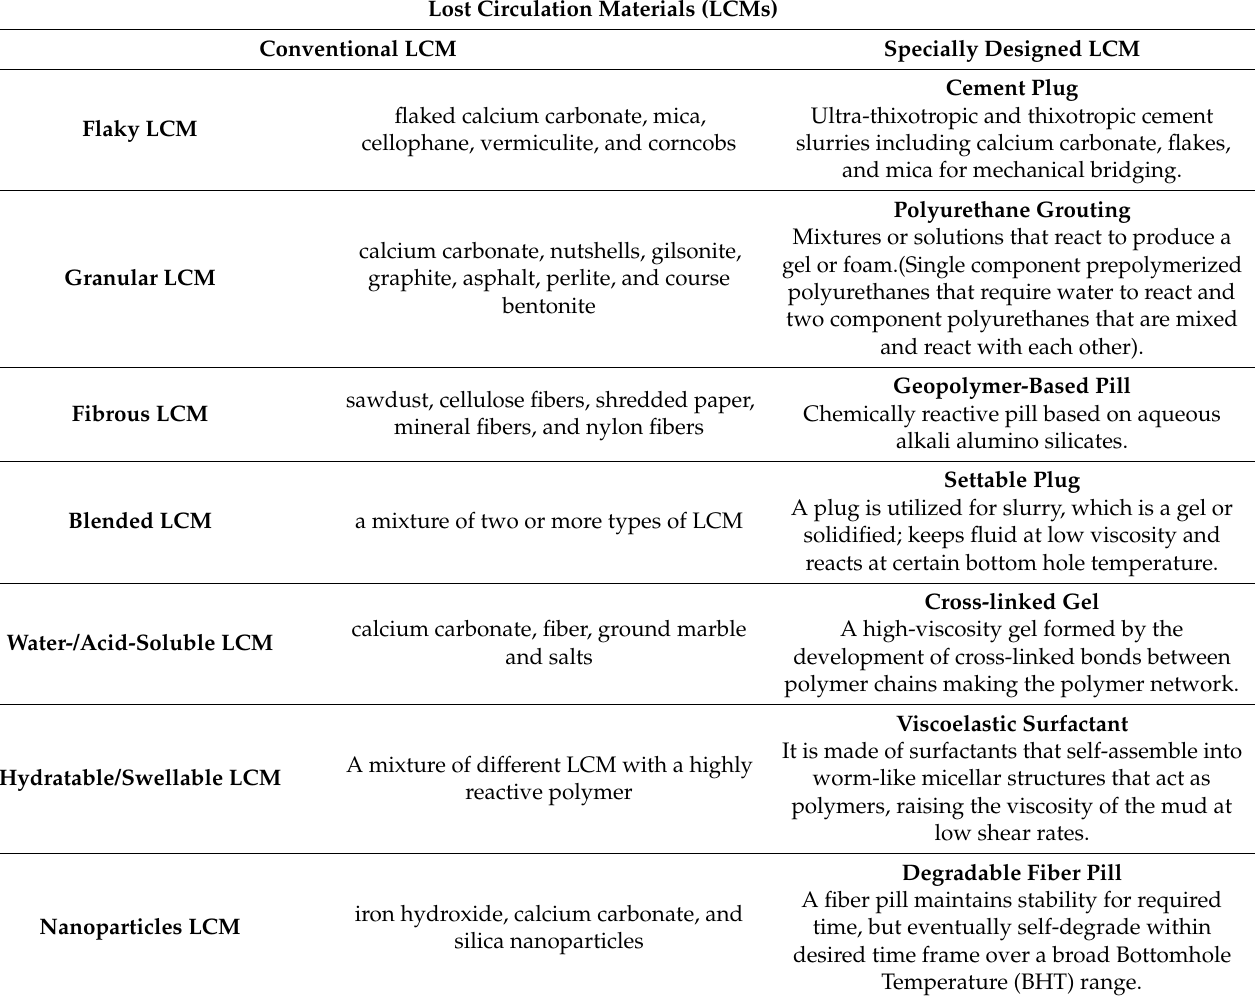
Table 5. Lost circulation materials